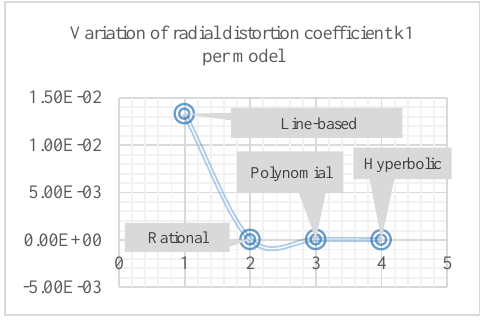
Figure 1: Variation of distortion coefficient per model